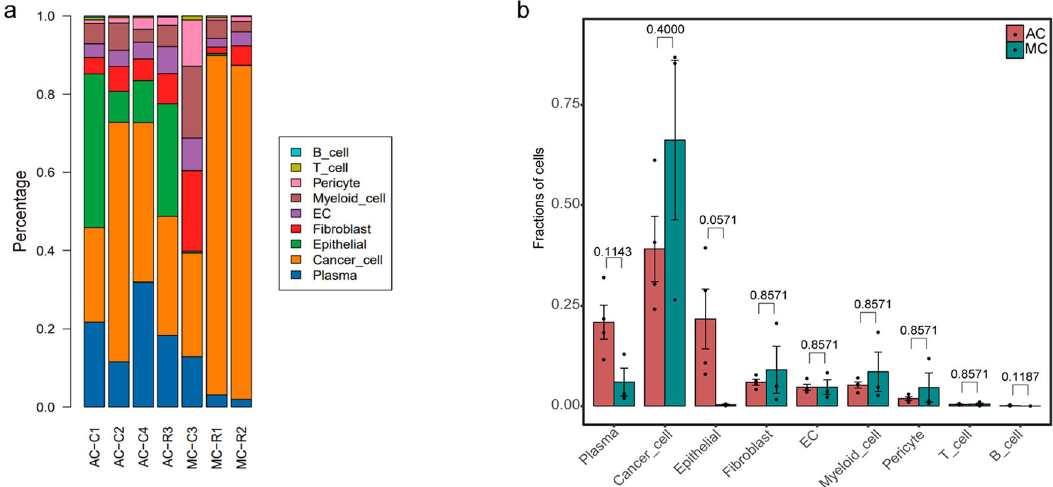
Fig. 2 Proportion of the nine cell subtypes. a Proportion of the nine cell subtypes among seven samples. b Histogram indicating the proportions of nine main cell clusters in the two groups. The analysis was performed using unpaired two-tailed Wilcoxon rank-sum tests, and statistical signi fi cance was set at p < 0.05. The error bars represent mean ±